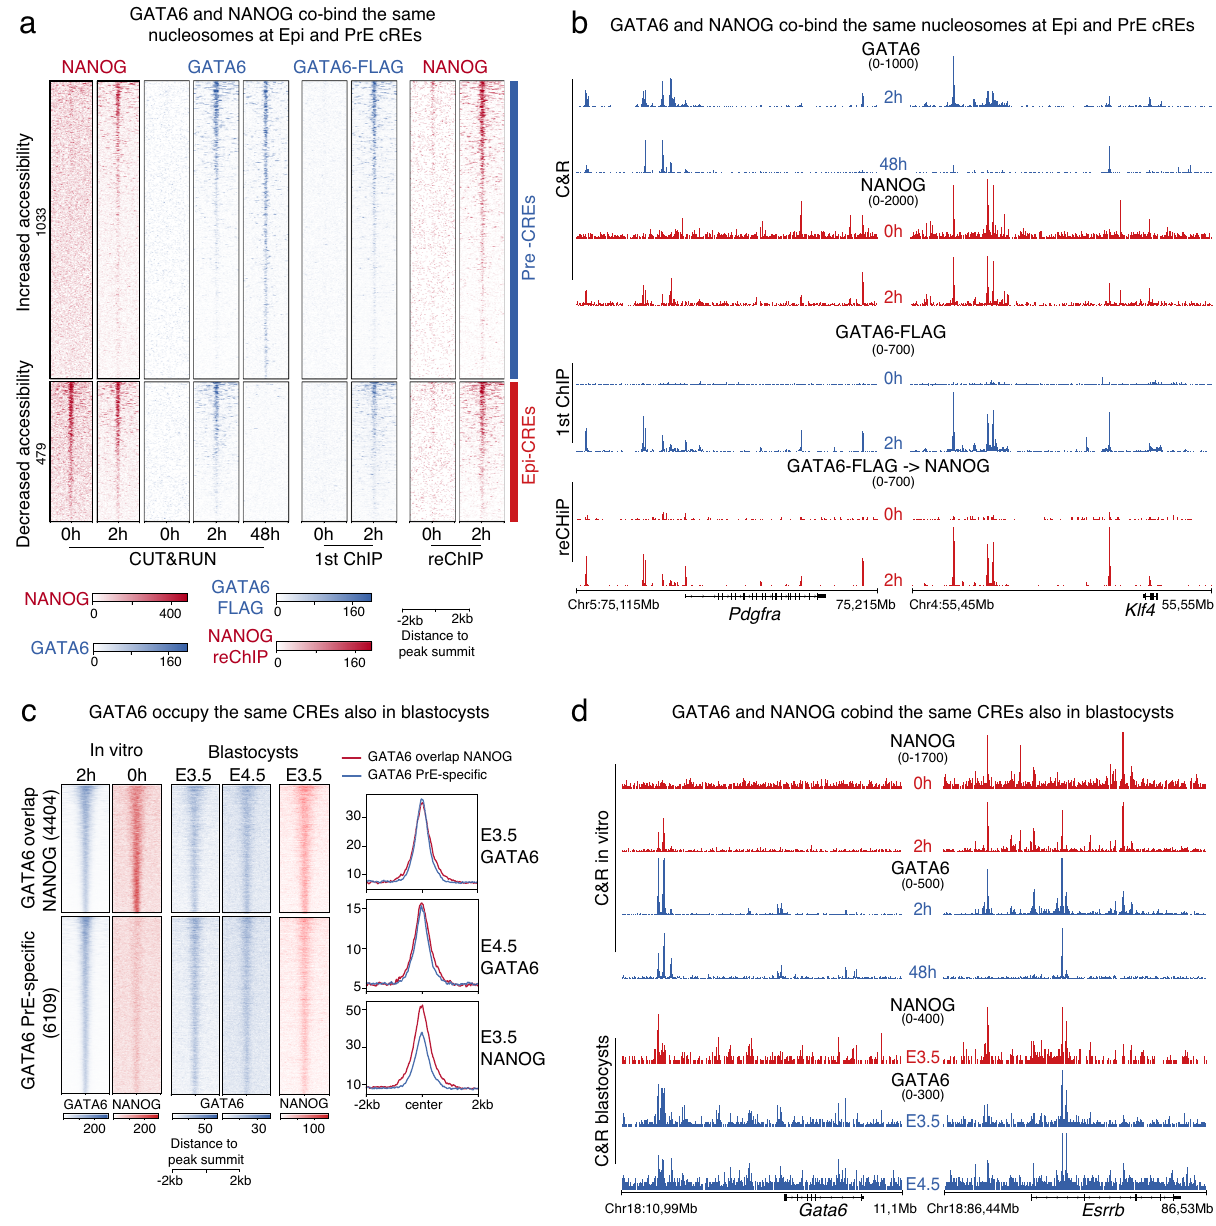
Fig. 5 GATA6 and NANOG co-bind at Epi and PrE CREs in vitro and in vivo. a Heatmap showing enrichment of NANOG reChIP signal at FLAG-bound Epi and PrE CREs that lose and gain accessibility during PrE differentiation. b Representative browser view showing that at 2 h NANOG and GATA6 co-bind at CREs proximal to the Pdgfra and Klf4 genes. GATA6 and NANOG CUT&RUN signals are included to compare with signal from reChIP. c Extensive co- binding of GATA6 and NANOG to Epi-CREs also occurs in blastocysts. Heatmap and median pro fi le plot comparing GATA6 and NANOG CUT&RUN patterns in blastocysts, to in vitro GATA6 and NANOG binding at 0 h and 2 h of GATA6-driven differentiation. d Example of GATA6 binding both at Epi ( Esrrb ) and PrE loci ( Gata6 ) in blastocysts. Source data are provided as a Source Data fi